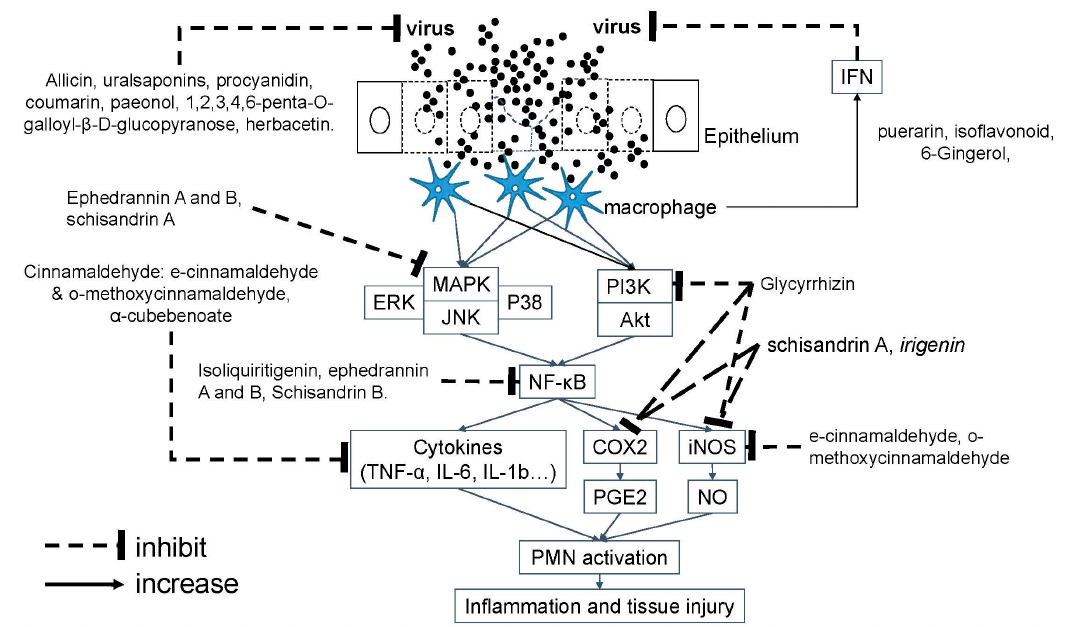
Figure 1. The molecular mechanism of TCM formulas against airway viral infections. Airway viruses infect the epithelium to cause tissue injury. TCM formulas of A-physicians contain several active molecules to inhibit viral replication and signal transduction of inflammatory response. Akt: Serine/threonine protein kinase B (PKB); COX: Cyclooxygenase; ERK: Extracellular signal-regulated kinase; IL: Interleukin; iNOS: Inducible nitric oxide synthases; JNK: c-Jun N -terminal kinases; MAPK: Mitogen-activated protein kinase; NF- κ B: Nuclear factor-kappa B; NO: Nitric oxide; PG: prostaglandin; PI3K: Phosphoinositide 3-kinase; PMN: Polymorphonuclear neutrophils; TNF: Tumor necrotic factor.